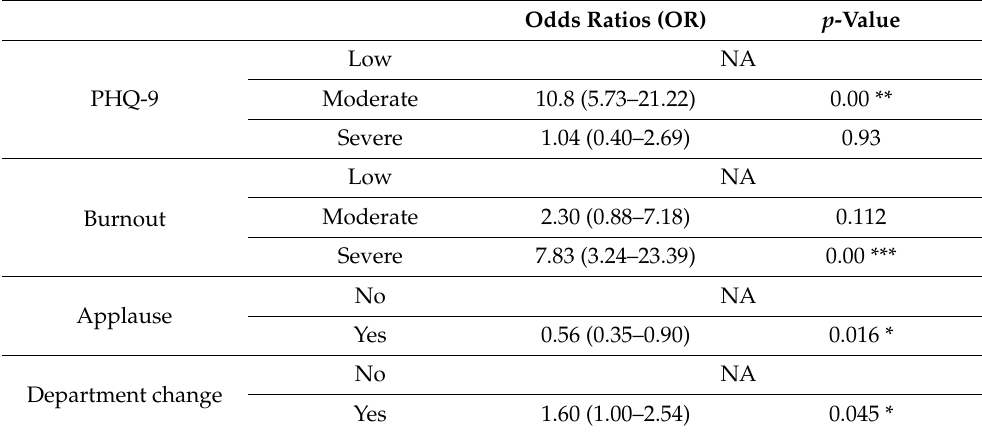
Table 3. Results of the multivariable logistic regression of the perception of job